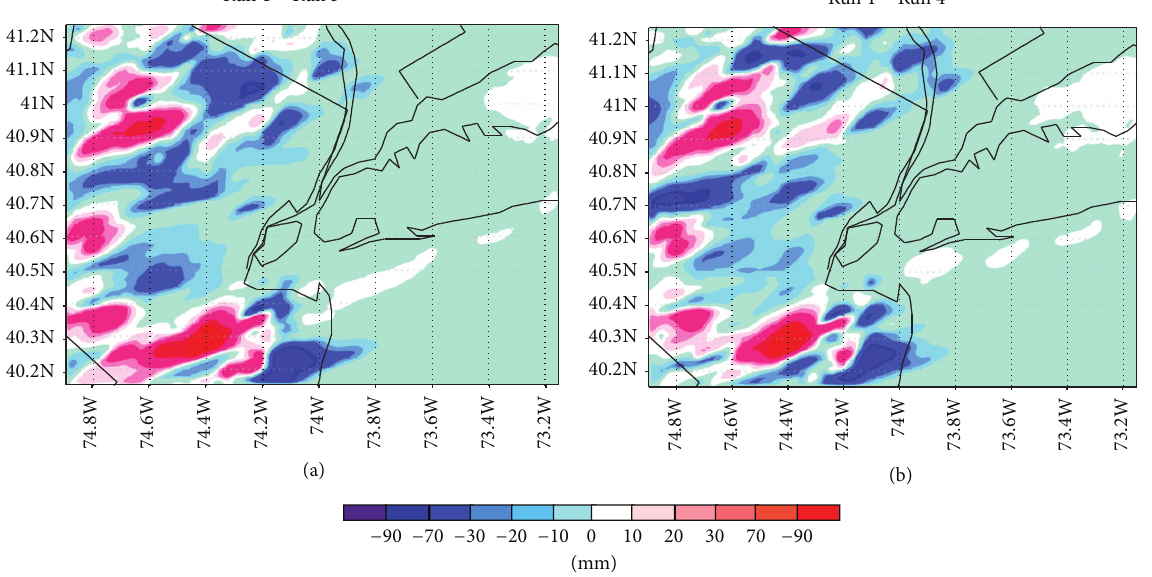
Figure 13: (a) Precipitation differences for Run 1 minus Run 3. (b) Precipitation differences for Run 1 minus Run 4.